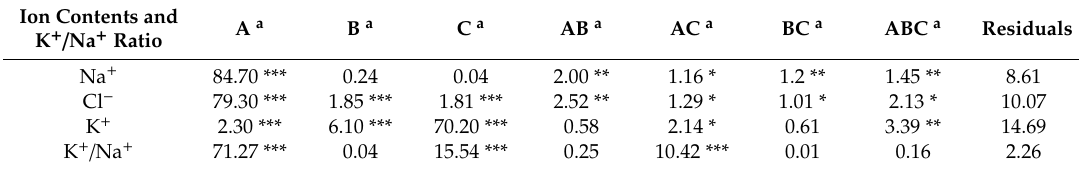
Table 3. Factorial analysis of variance (ANOVA) considering the effect of treatment (A), species (B), organ (C), and their interactions (A × B; A × C; B × C; A × B × C) on ions (Na + , Cl − , K + ) contents and the K +/ Na + ratio, in Solanum melongena and S. insanum . Numbers represent percentages of sum of squares (SS). Ion Contents and A a B a C a AB a K + / Na + Ratio Cl −